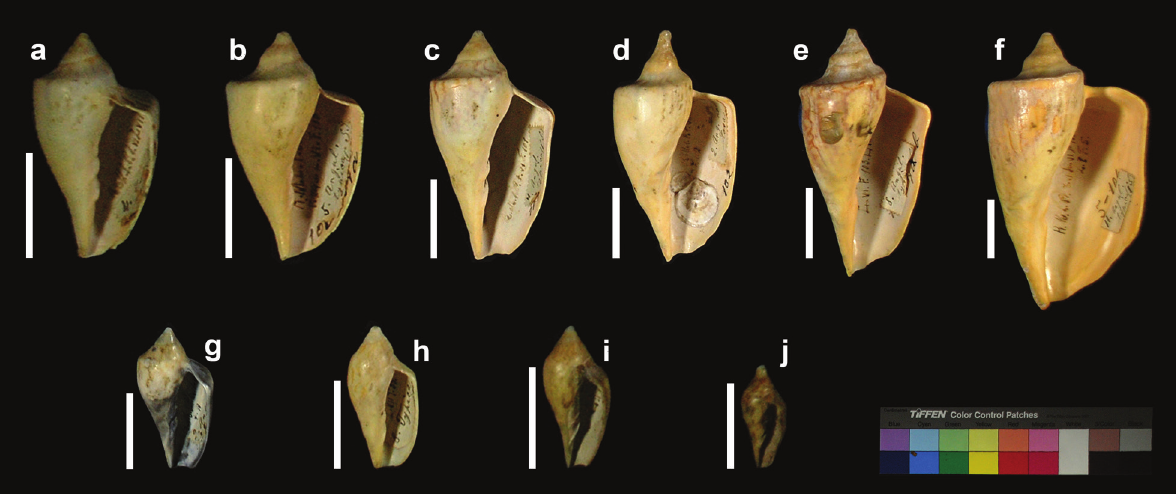
Figure 15. Voluta angulata typica , specimens figured by Lahille (1895). See references on Table 4. Scale bars: 3 cm.